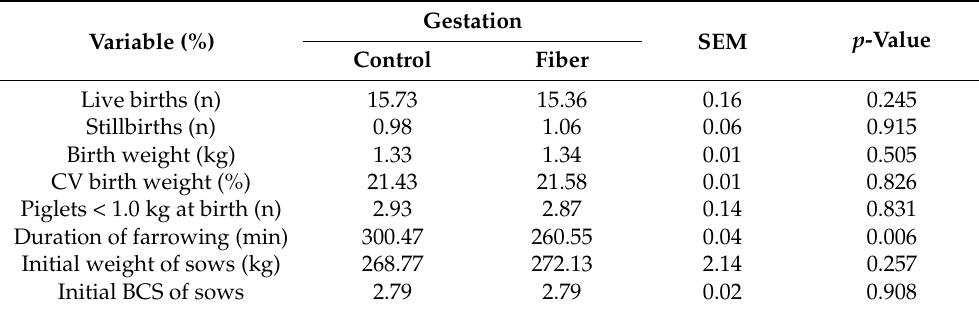
Table 6. Number of piglets born alive, stillbirths, average piglet weight at birth, litter uniformity (coefficient of variation of birth weight and piglets weighing less than 1.0 kg at birth), farrowing duration, weight, and BCS of sows entering the farrowing unit supplemented or not with dietary fiber during gestation.